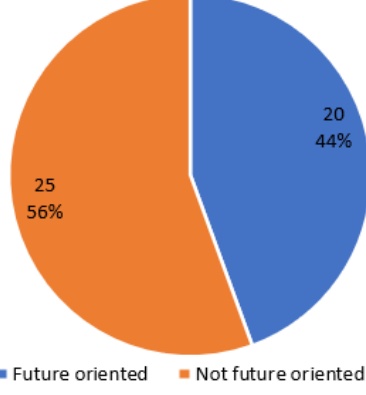
Figure 9. Future consideration of the studies.